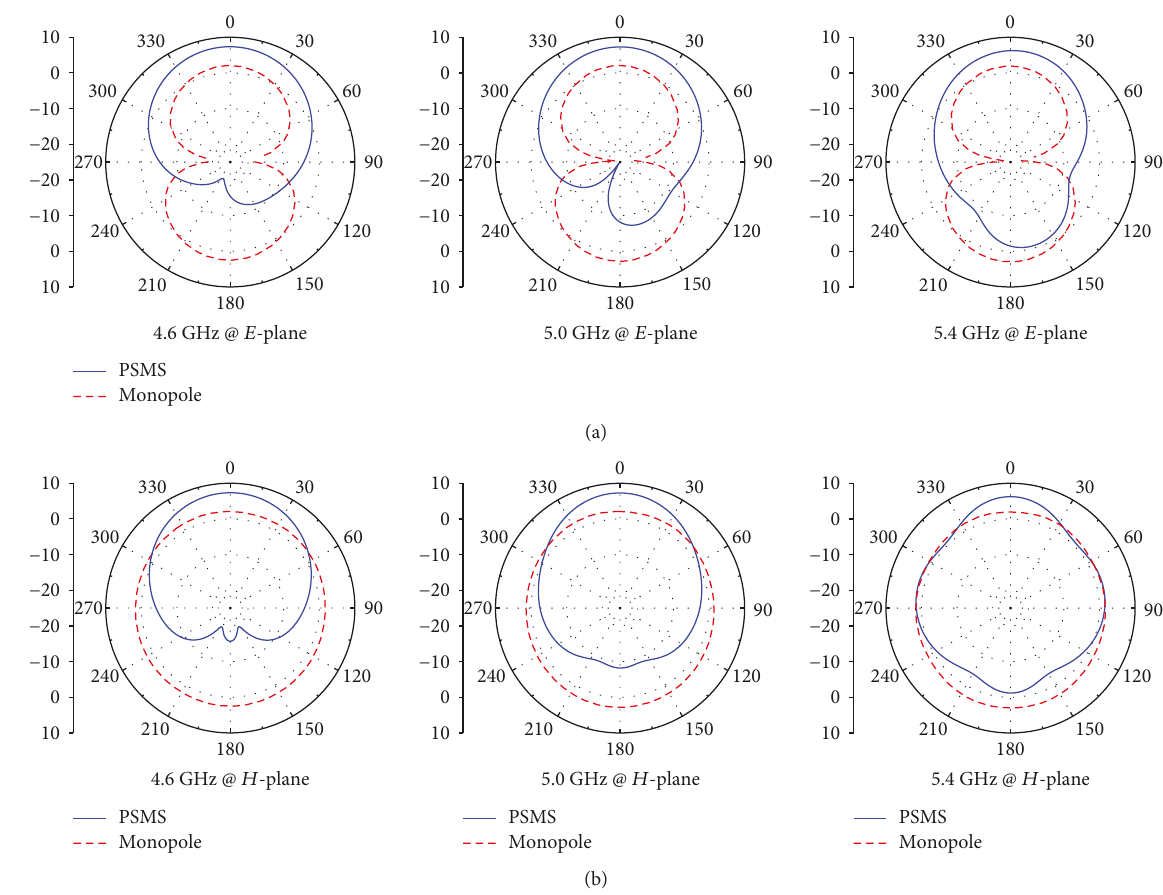
Figure 5: Radiation patterns for the monopole and the PSMS antenna in (a) E -plane and (b) H -plane at 4.6, 5.0, and